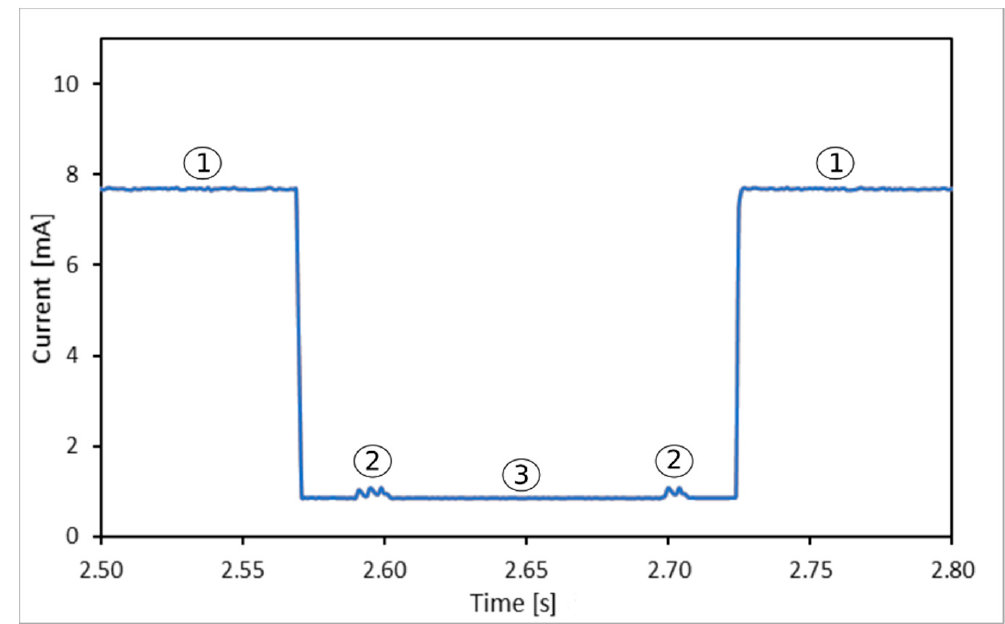
Figure11. Figure 11. Power consumption of the tag after receiving a “write” command at 4.2 V in the supercapacitor. As in other images, the numbers represent which element is the one that has the largest contribution to the consumption of the tag in that interval in each case: 1 is for the transceiver, 2 is for the EEPROM, and 3 is for the microcontroller. The EEPROM is used twice, once to find where to save the datum and a second time to save it. After that, the processing associated with the command ends. The microcontroller remains active while the checks are being made and the data is saved.